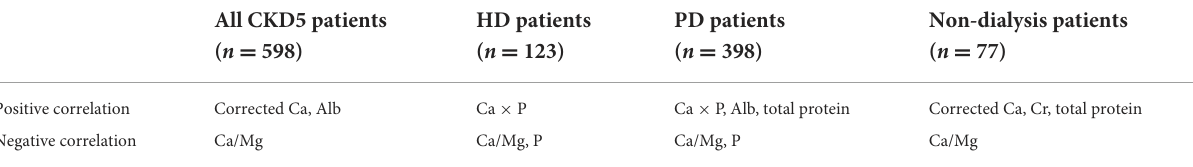
All CKD5 patients ( n = 598)